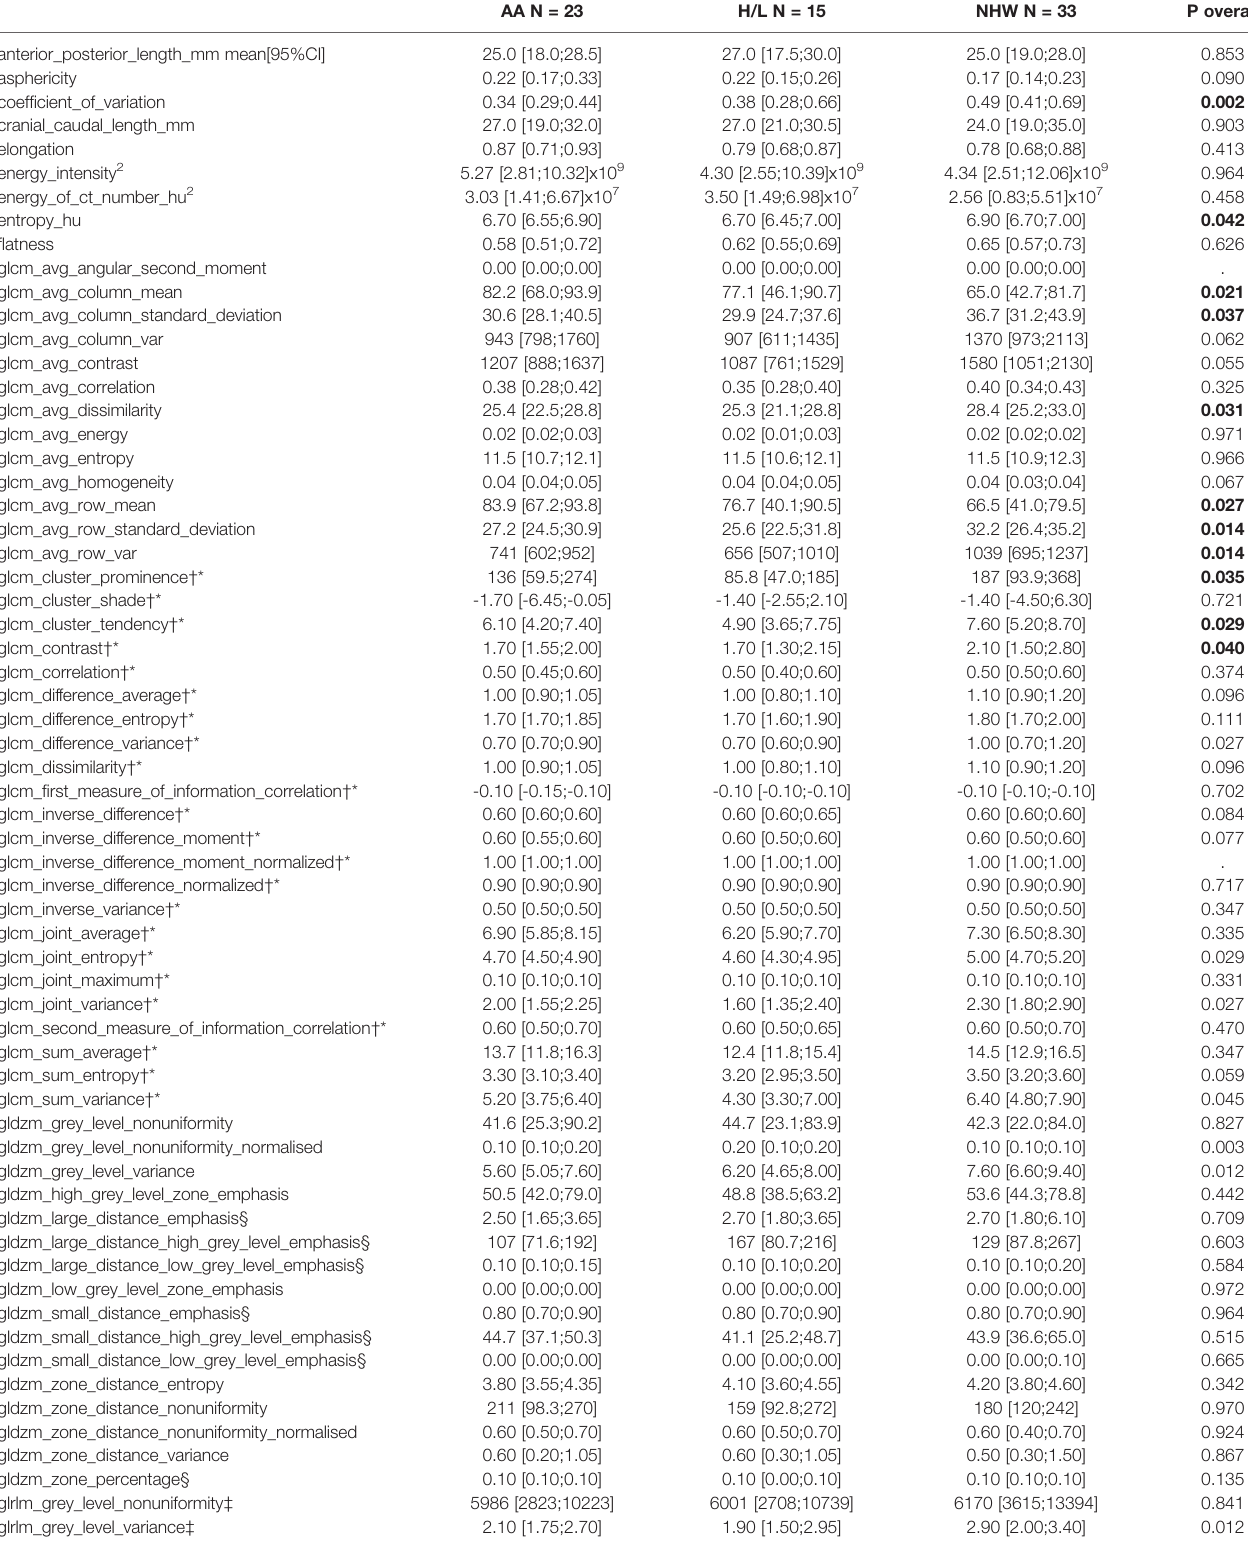
TABLE 4 | Radiomic features evaluated in this study and their univariate association with race/ethnicity. AA N = 23 H/L N = 15 NHW N = 33 P overall anterior_posterior_length_mm